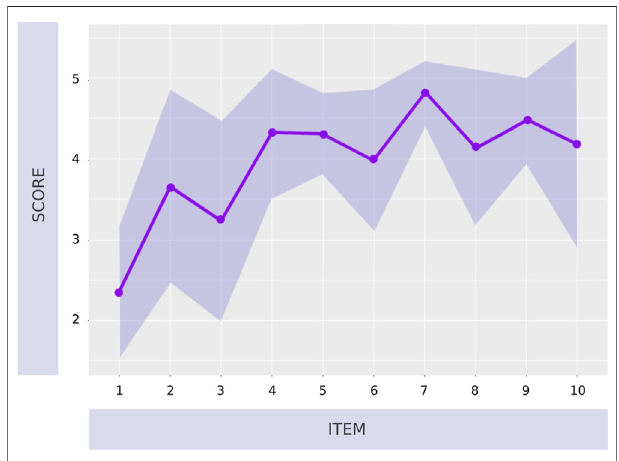
FIGURE 4 | Results of the subjective questionnaire regarding the usefulness and functionalities of the application and ergonomics of the MR device. Results are presented as mean values and standard deviations (shaded area around the main plot).